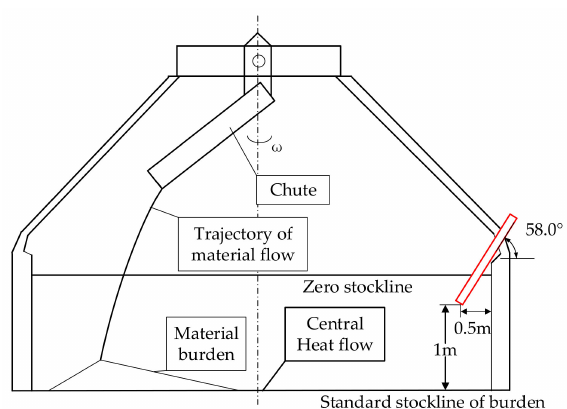
Figure 7. Schematic diagram of installation of high-temperature industrial endoscope.